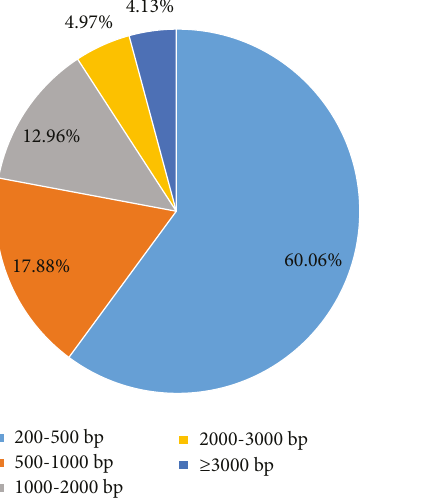
Figure 1: Size distribution of the lengths of Helicoverpa assulta midgut unigenes.